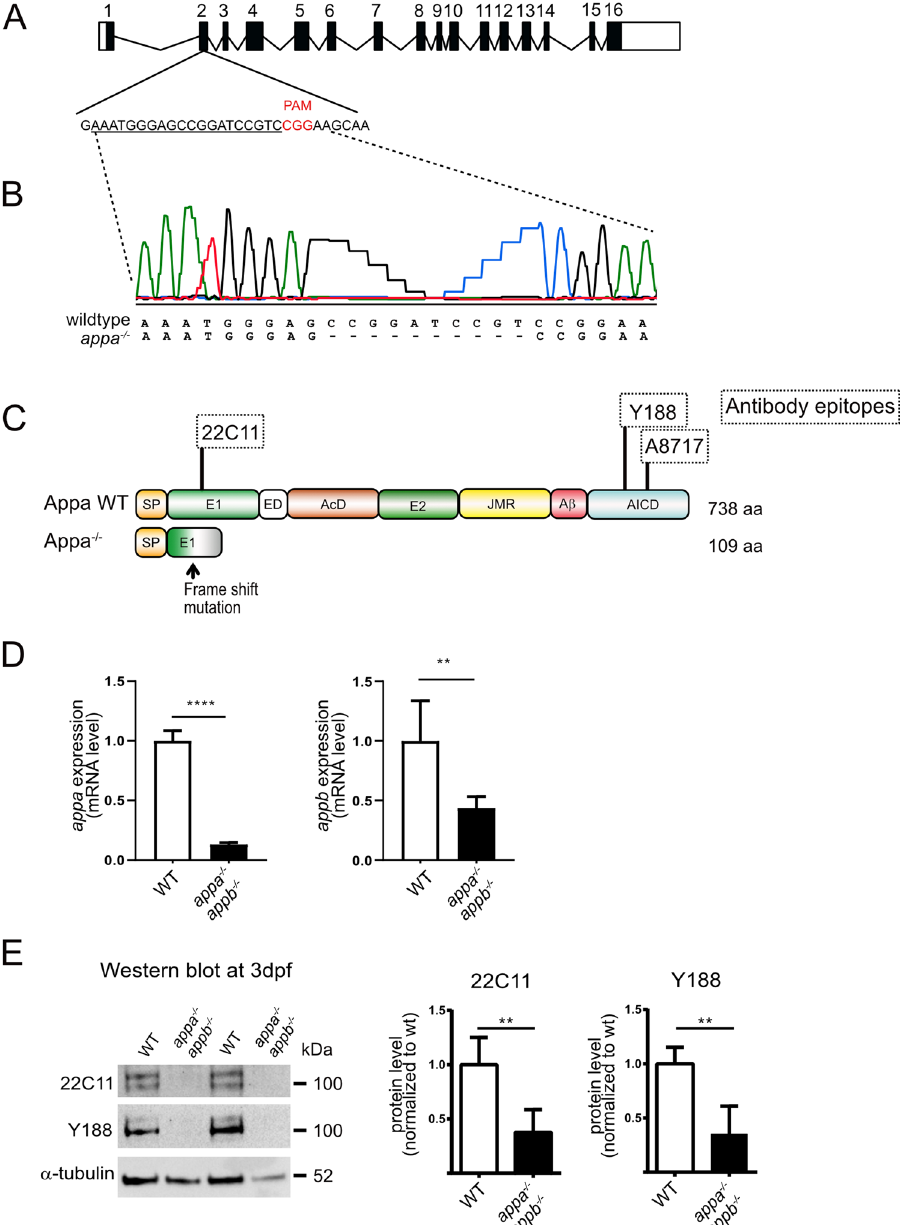
Figure 6. Generation of appa −/− and analysis of appa −/− appb −/− double mutant zebrafish. ( A ) Schematic outline of the appa gene with exons (black box) and UTR regions (white box). sgRNA used to target exon 2 with protospacer adjacent motif (PAM) in red and the sgRNA target sequence underlined. ( B ) Sanger sequencing chromatogram of the exon 2 region targeted in wild-type zebrafish. The appa −/− mutant sequence is given below with dash indicating deleted nucleotides. ( C ) Schematic drawing of the wild-type Appa protein (738 aa) with epitopes of antibodies (dotted squares) used above and the hypothetical truncated Appa (109 aa) protein produced in appa mutant below. ( D ) qPCR quantification of appa and appb mRNA levels in wild-type and appa −/− appb −/− mutants at 24 hpf. ( E ) Western blot of 3 dpf whole larvae zebrafish with antibodies against 22C11 and App (Y188). Alpha-tubulin is used as loading control. Blots cropped from the same original gel and grouped. Quantification of band intensity are shown relative to control. Data are reported as mean ± SD. ** ρ < 0.05, **** ρ < 0.001. qPCR n = 5, WB n = 3. SP signal peptide, E1 extracellular domain, ED extension domain, AcD acidic domain, E2 extracellular domain 2, JMR juxtamembrane region, Aβ amyloid beta, AICD amyloid intracellular